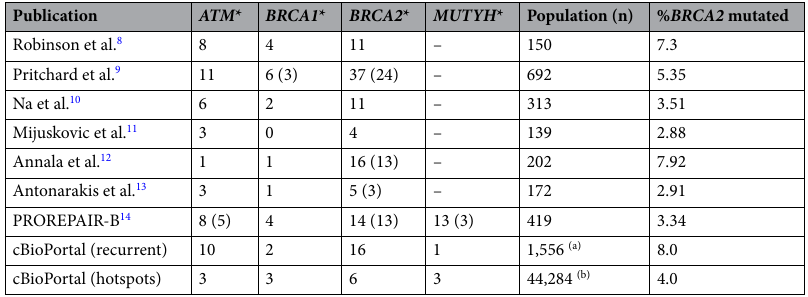
genic germline variants versus their benign and VUS counterparts in BRCA2. The same significant tendency was observed in BRCA2 for the distribution of VUS versus benign, both in the ClinVar dataset. No significant differences were observed in the distribution of somatic variants between primary and metastatic tumours. In ATM (Fig. 6, panel a), the pathogenic germline variants from different mCRPC cohorts, TCGA, and Clin- Var datasets show a tendency to accumulate in the interaction region with the NF-κ B essential modulator IKBKG (NEMO) (a.a. 1960–2565; IntAct accessions: EBI-495465 and EBI-81279), that overlaps a flexible region flanking